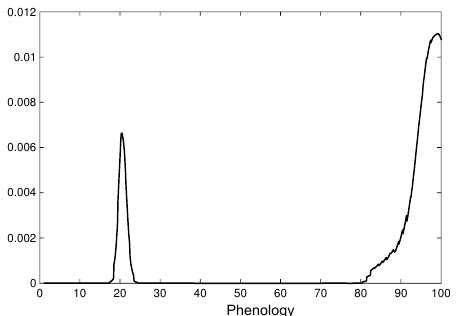
Figure 10. Representation of the likelihood PDF of the observations for a value of NDVI close to